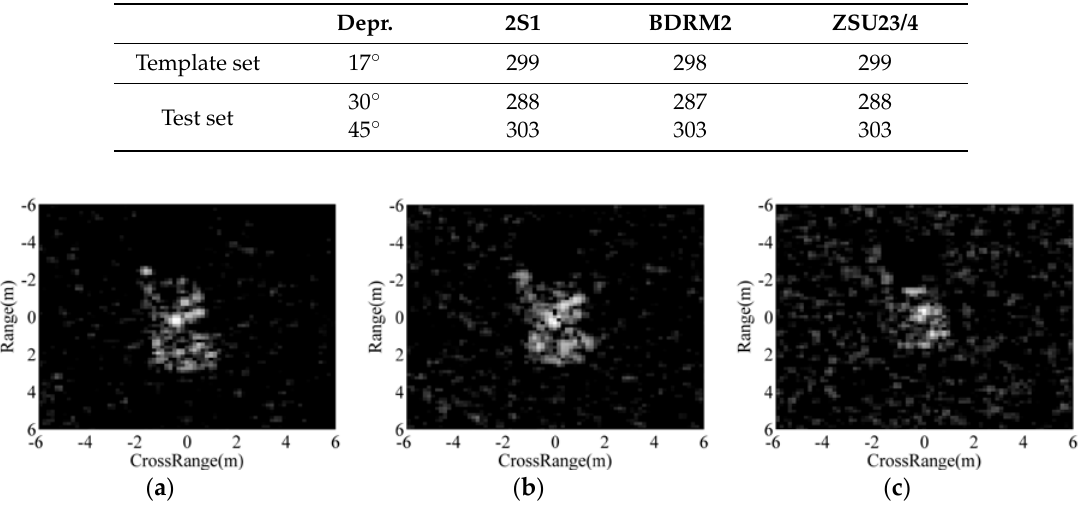
Table 8. Dataset with large depression variance.